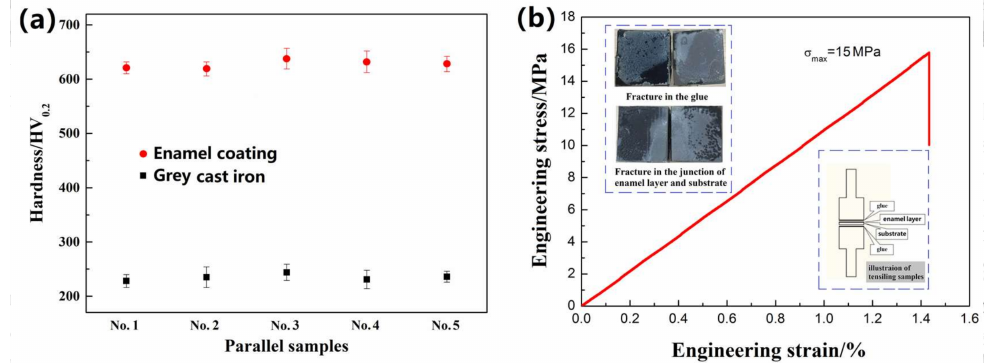
Figure 8. Mechanical property of the samples. ( a ) The micro-hardness of the enamel coating and grey cast iron substrate. ( b ) The bonding stress between the enamel coating and the